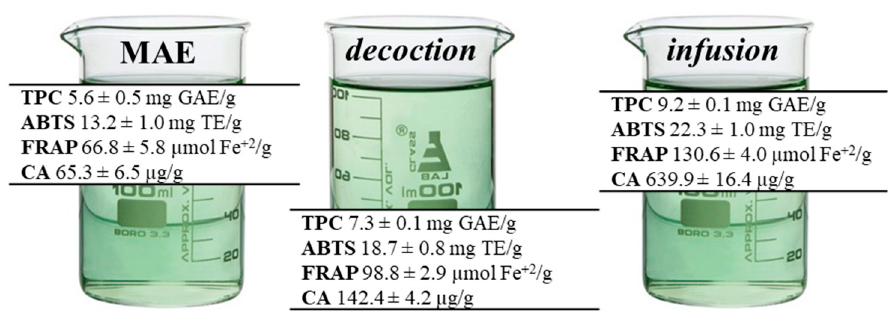
Figure 3. TPC, ABTS, FRAP, and CA content of L. barbarum leaf MAE, decoction, and infusion extracts .